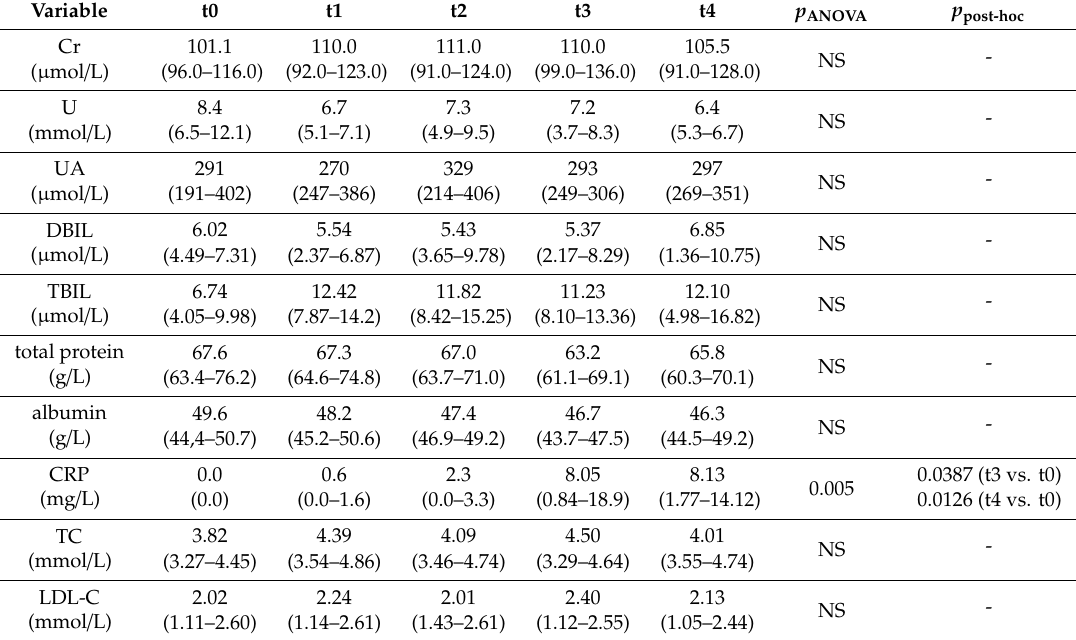
Table 4. The values of biomarkers in participants’ blood during the training